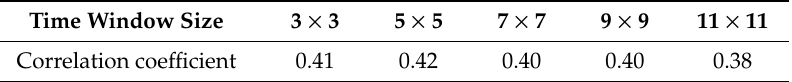
Table 5. Correlation coe ffi cient for di ff erent time windows with 20% noise.